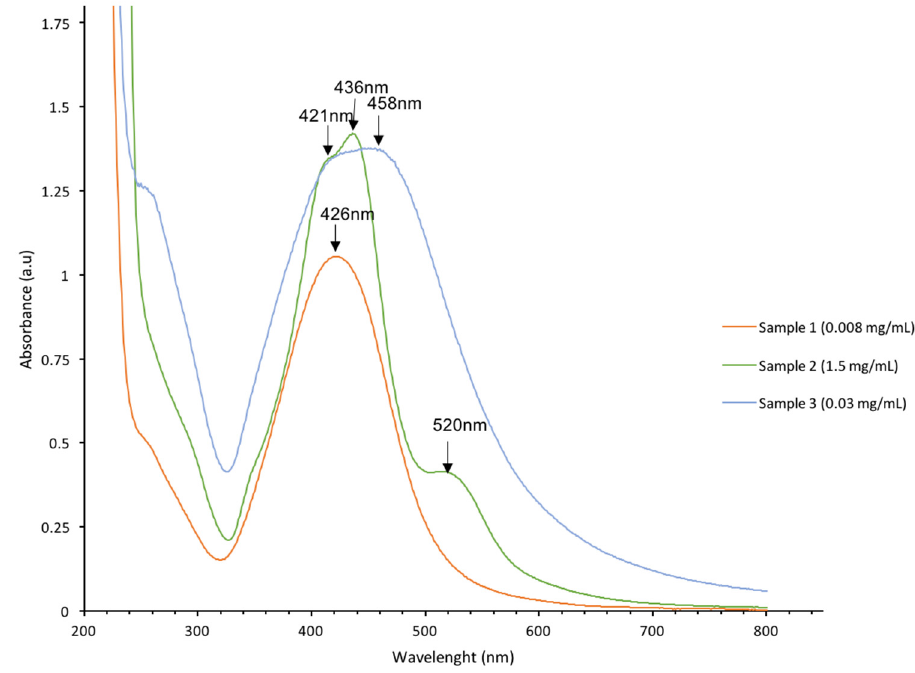
Figure 2. UV-visible spectra of AgNPs samples #1–3 with concentrations of: sample #1—0.008 mg/mL; sample #2—1.5 mg/mL; and sample #3—0.03 mg/mL.